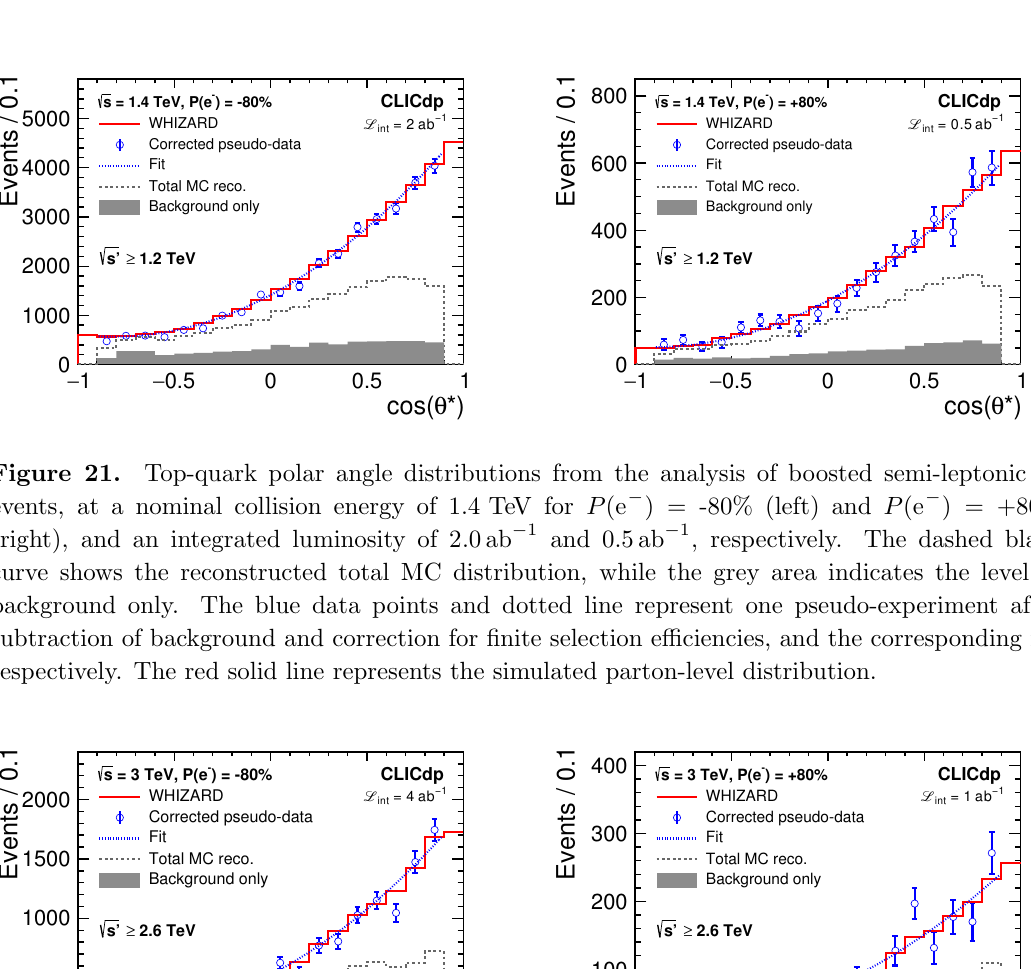
tial MVAs are trained focussing on slightly di(cid:11)erent topologies. The (cid:12)rst MVA is trained using backgrounds with two quarks and either 0, 1, or 2 leptons, while the second